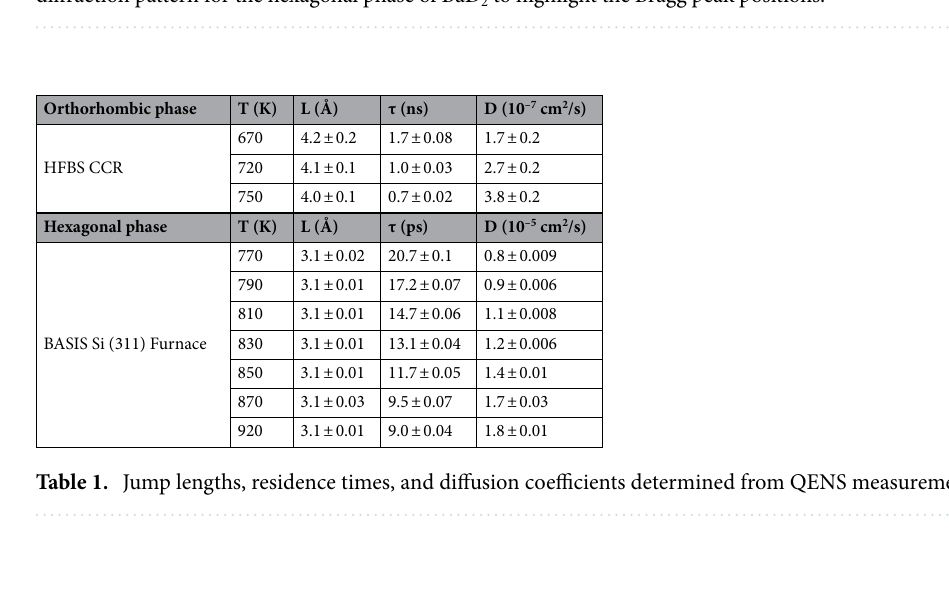
Figure 3. Comparison of QENS spectra fits with the constrained jump diffusion models (Supplementary equations (S7, S8 and S9)) to the unconstrained data fit (Eq. (1)) performed with QClimax . The three jump diffusion models are Chudley–Elliott, Singwi–Sjölander, and Hall–Ross 27–29 . Also shown is the neutron powder diffraction pattern for the hexagonal phase of BaD 2 to highlight the Bragg peak positions.